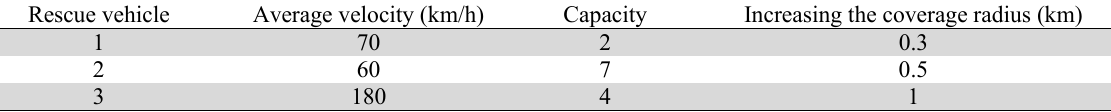
rescue vehicles’ information and characteristics Rescue